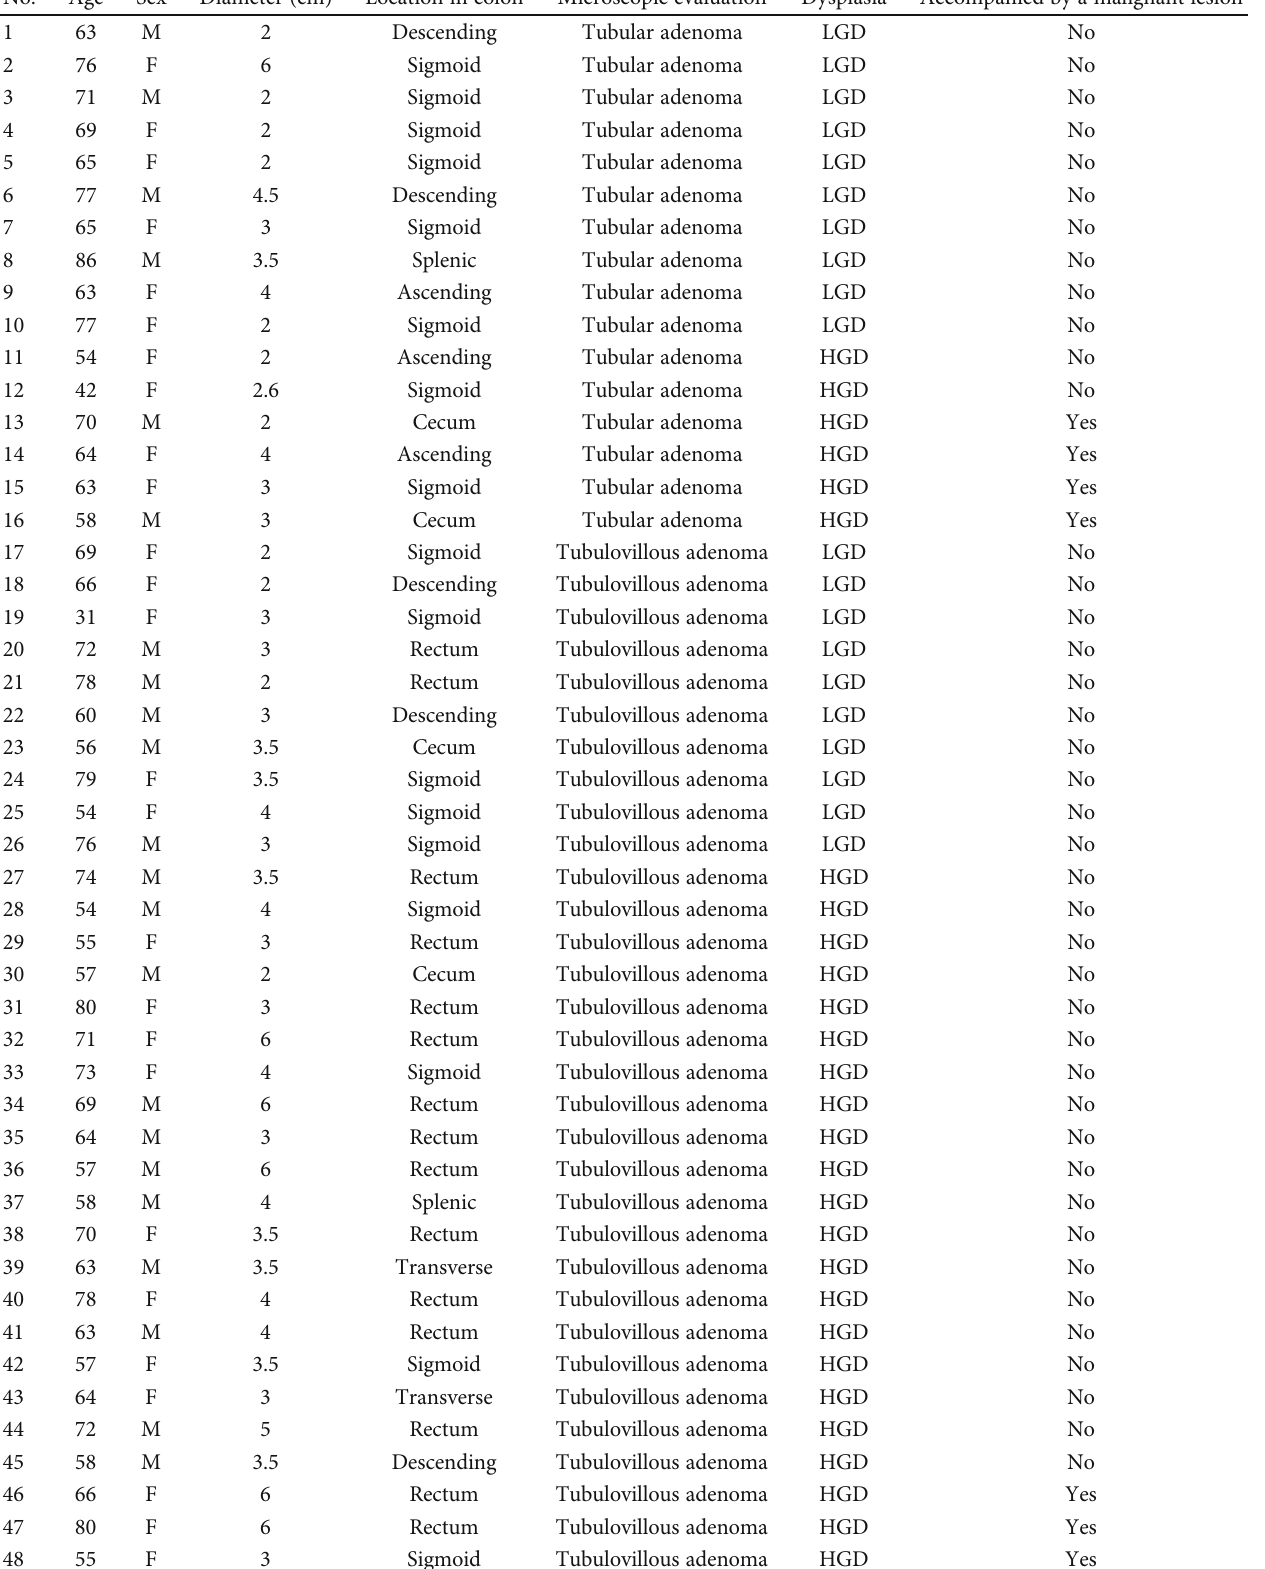
Table 1: Clinicopathologic parameters of 58 patients with colorectal